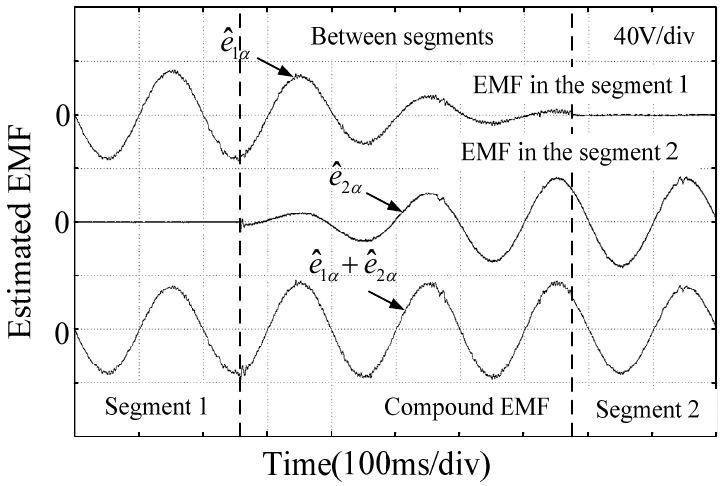
Figure 11. The back-EMF by the disturbance